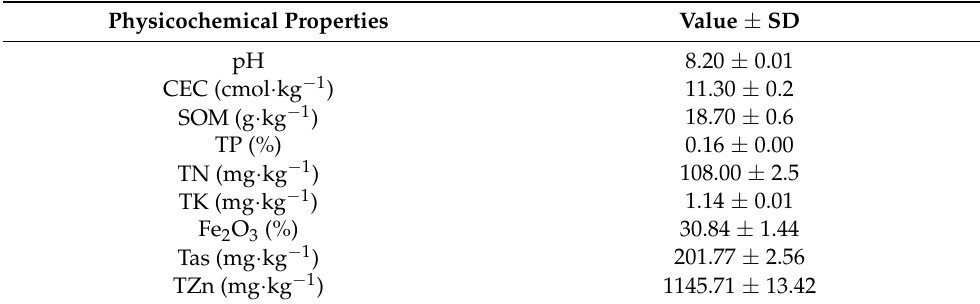
Table 1. Physicochemical properties of the experimental